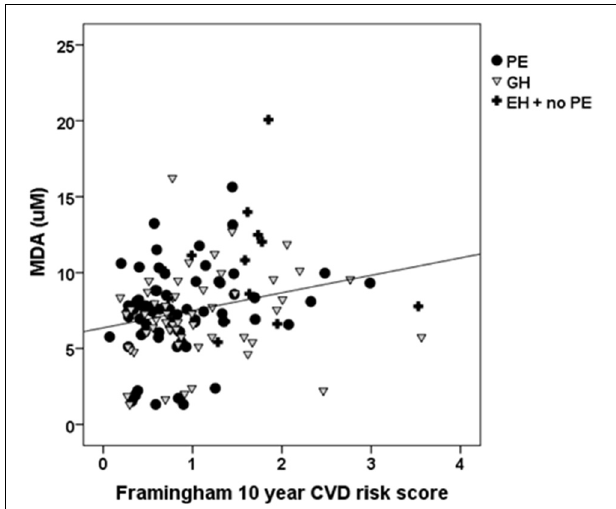
FIGURE 4 | The relationship between lipid peroxidation, measured by TBARS-MDA, at 6 weeks postpartum, and a cardiovascular disease risk score, the Framingham 10 year index ( R 2 = 0 . 061, r = 0 . 248, P =